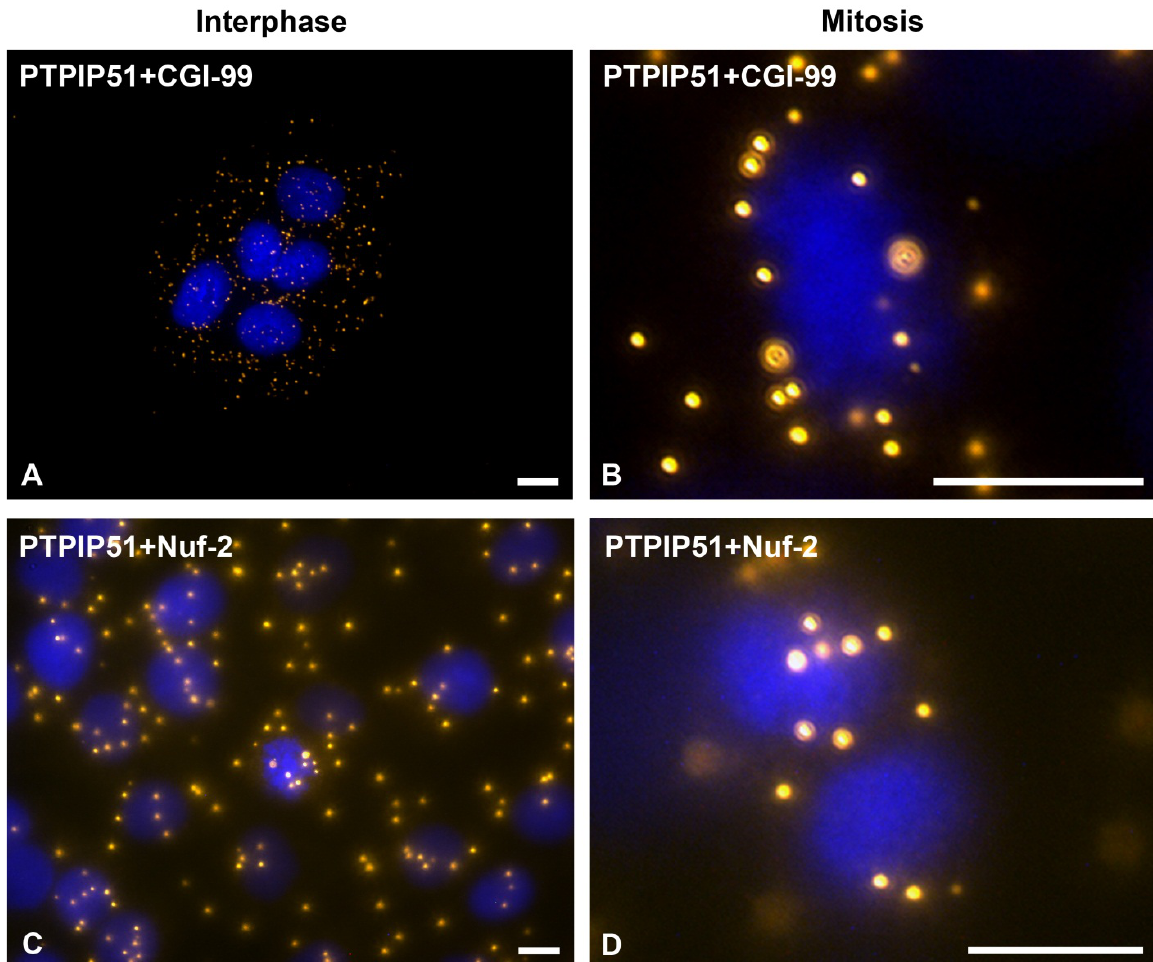
Figure 9. DPLA of PTPIP51 with CGI-99 and Nuf-2 in interphase and during mitosis. ( A ) DPLA of PTPIP51 and CGI-99 in interphase. ( B ) DPLA of PTPIP51 and CGI-99 in a mitotic cell of the metaphase. ( C ) DPLA of PTPIP51 and Nuf-2 during interphase. ( D ) DPLA of PTPIP51 and Nuf-2 in a mitotic cell of the metaphase. PTPIP51 antibody: P51ab. Nuclei are marked by Dapi. Bar: